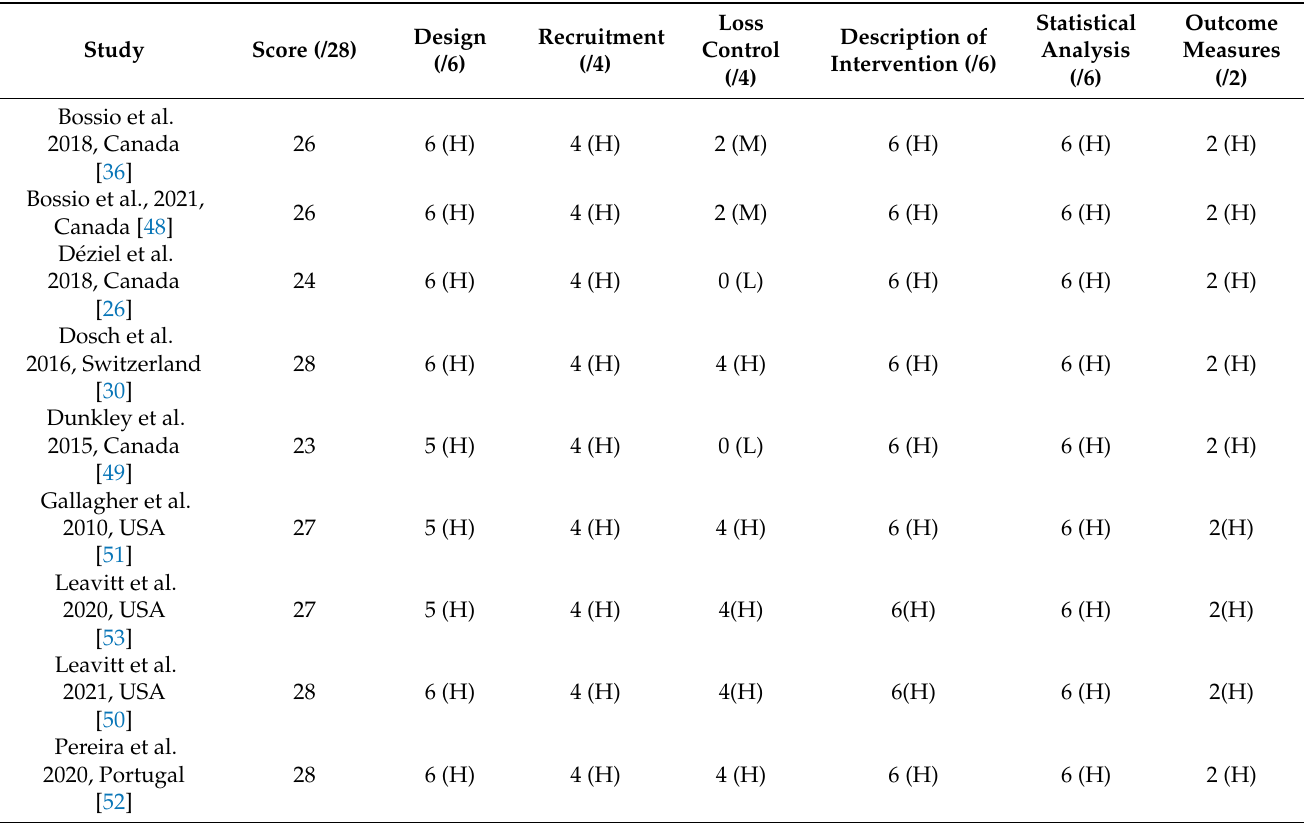
Table 2. Estabrooks scale for a non-randomized control trials.